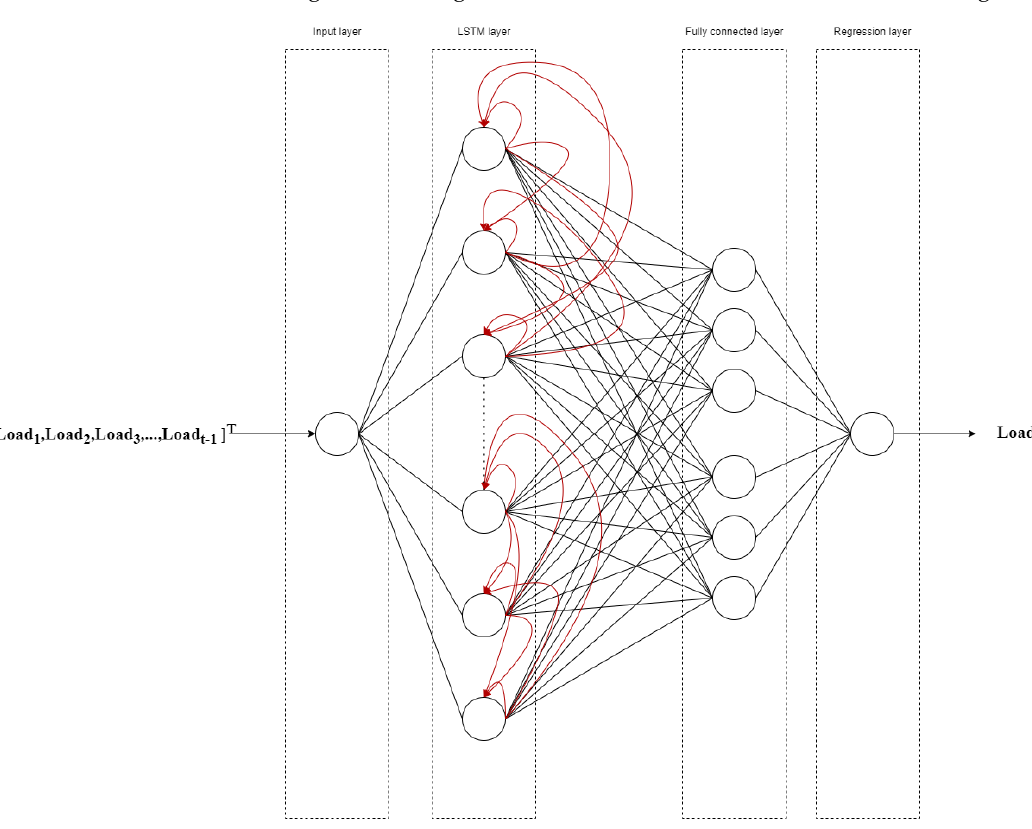
Figure 6. Signal flow diagram of an LSTM network.